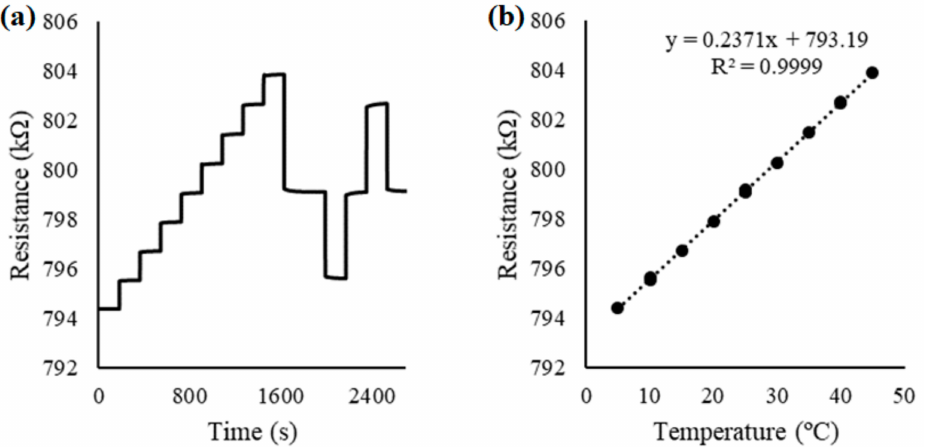
Figure 7. Electric resistance variations recorded for a RuO 2 electrode on alumina substrate, at 5 to 45 ◦ C ( a ); and the reversible linear temperature response of the electrode ( b